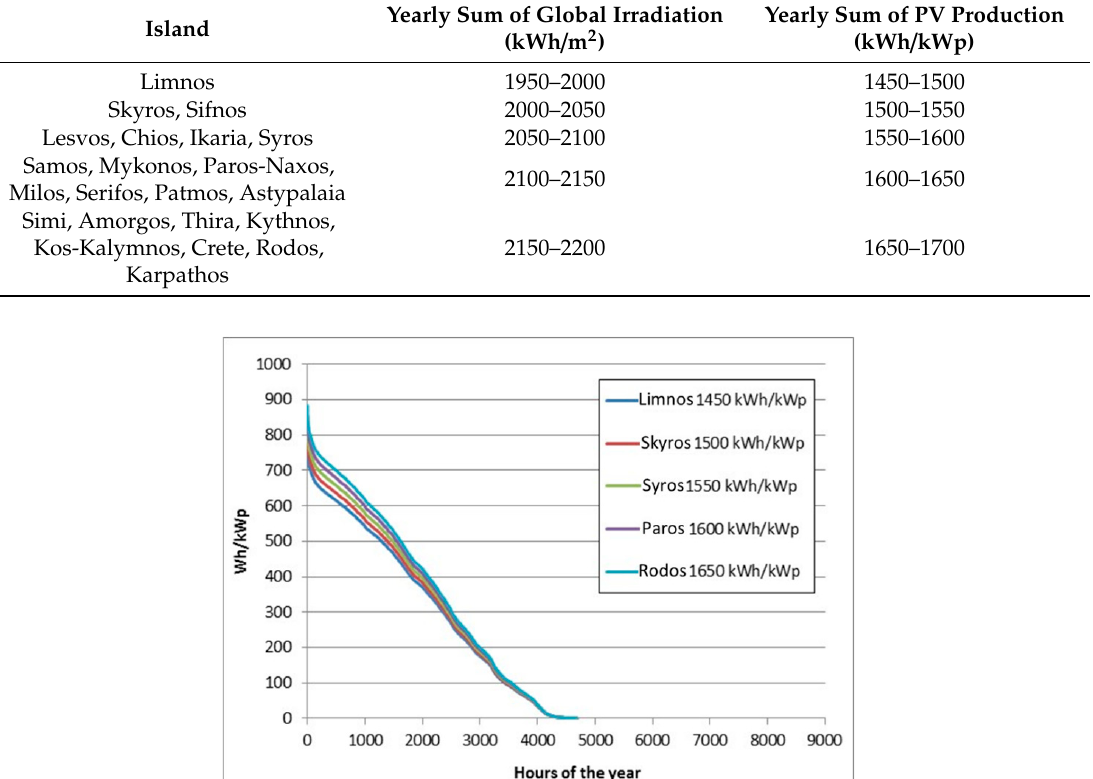
Figure 11. Annual duration curves of PV power output for five representative islands: 1450–1650 kWh/kWp.